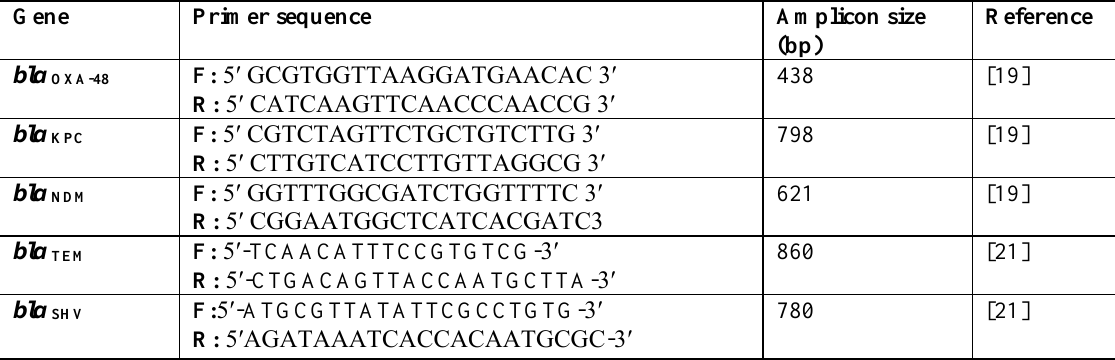
Table 1. Sequences of the primers and products of